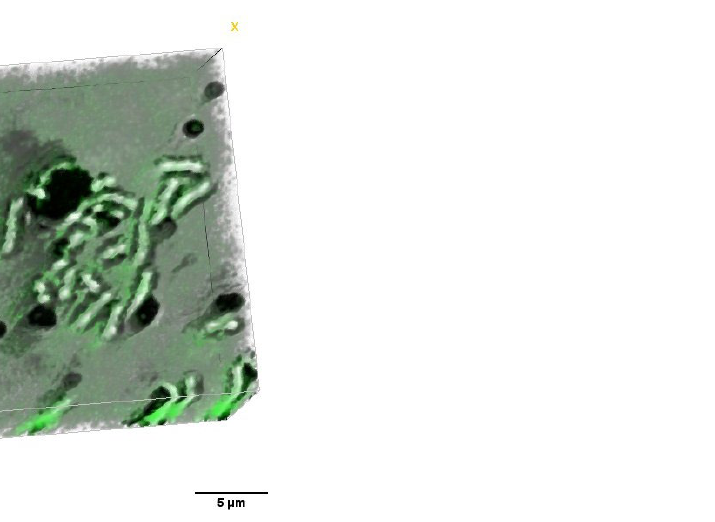
10 of 18 Figure 8. Digitally stained (based on the RI values) photosensitizer aggregates ( A ) Ce6 + Pheo, ( B ) Ce6, and ( C ) Pheo after 48 h incubation with PS. This effect can be explained by the mutual adhesion of cells and Ce6. The greater number of PS aggregates observed in the case of Ce6 may be caused by the mechanism of action of the efflux pump mechanism, which removes toxic substances from the cell into the surrounding medium and forms aggregates in the surroundings of the cells.